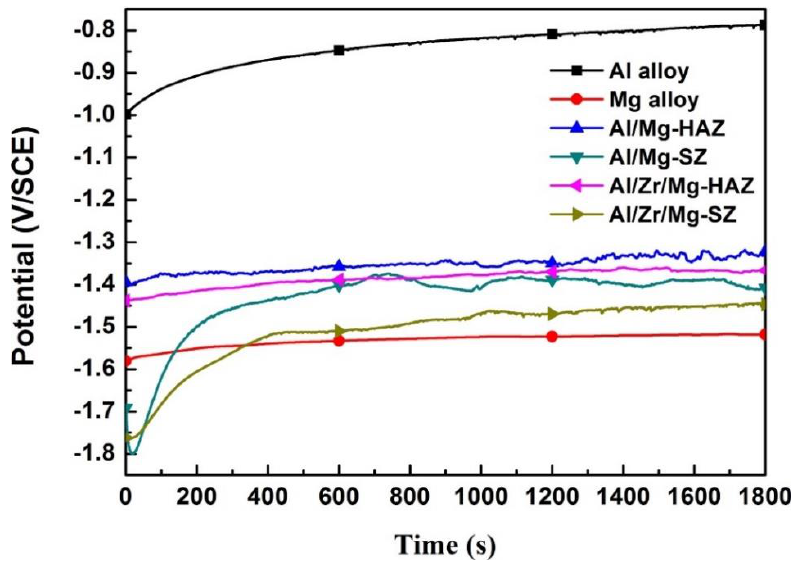
Figure 6. The open circuit potential (OCP) curves for the representative regions of the Al/Mg and Al/Zr/Mg joints in the 3.5% NaCl solution.